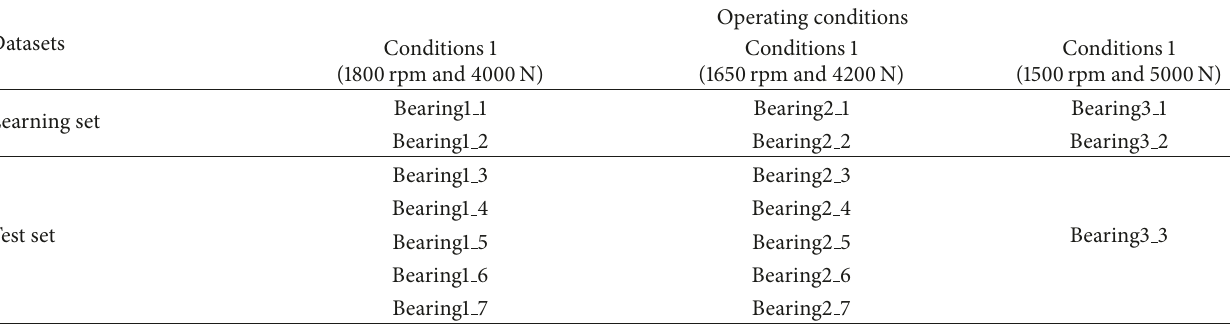
Table 2: Datasets of PHM 2012 Prognostic Challenge.